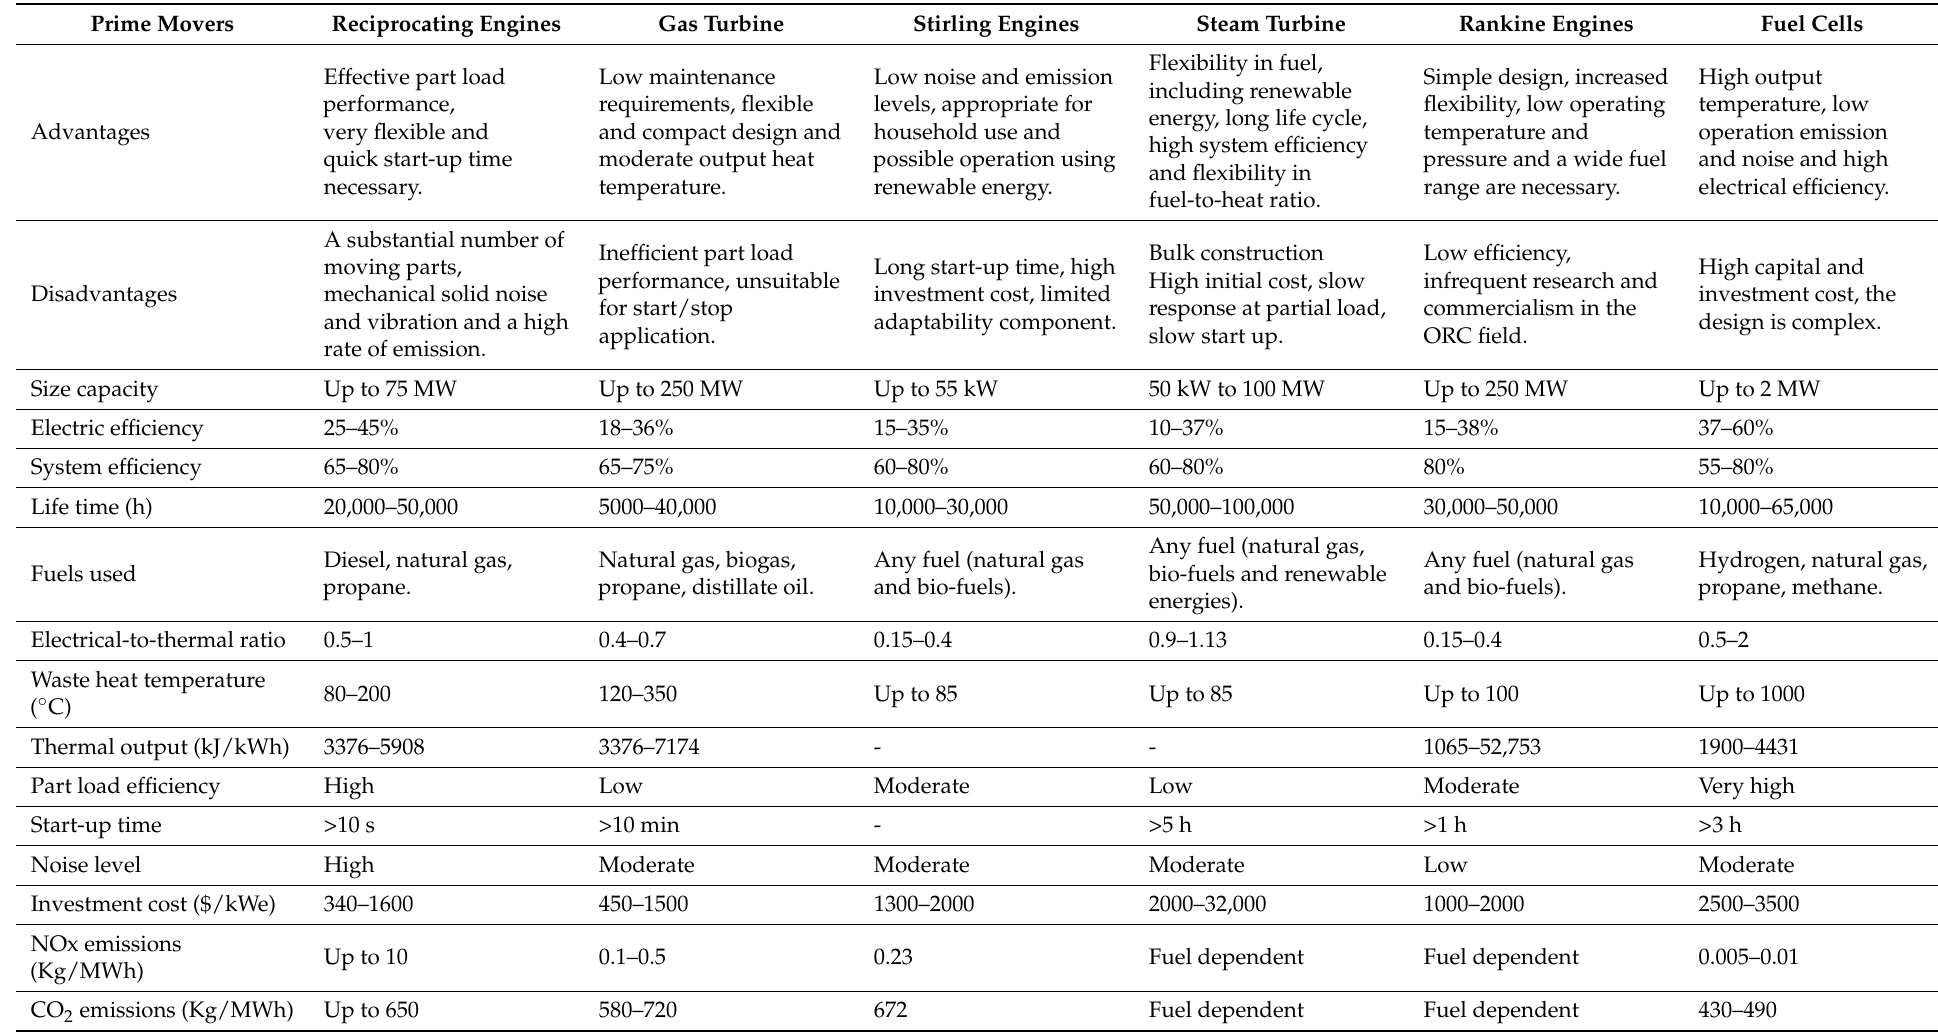
Table 1. Evaluation and comparison of several polygenerational prime movers